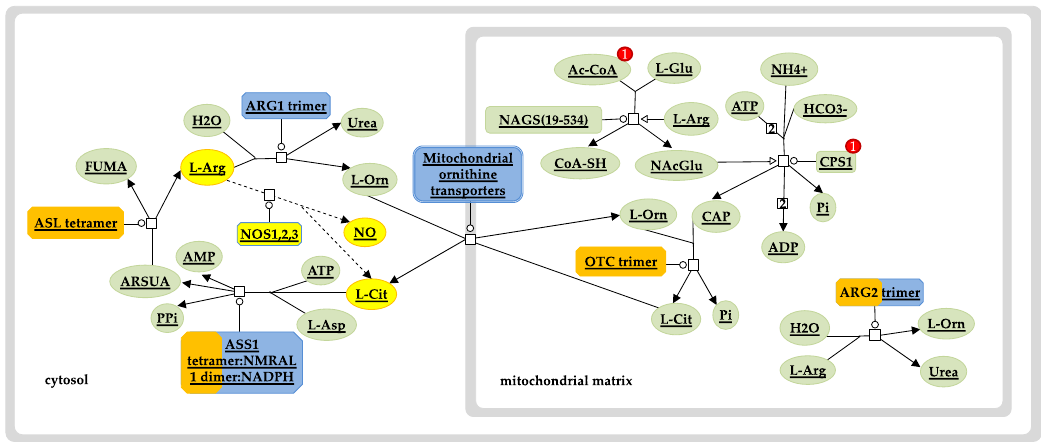
Figure 6. Urea cycle and nitric oxide pathway. Diagram depicts enzymes and intermediates of the urea cycle (solid lines) and the nitric oxide (NO) pathway (dashed lines, yellow nodes). Overrepresentation of the Hb F-related gene set used in the analysis is shown in orange. The size of the orange strip increases with the level of gene representation in the query set. The urea cycle pathway was exported from the Reactome pathway database and edited to include and highlight the role of NO shown in yellow. Ac-CoA, acetyl coenzyme A; AMP, adenosine monophosphate; ARG1,